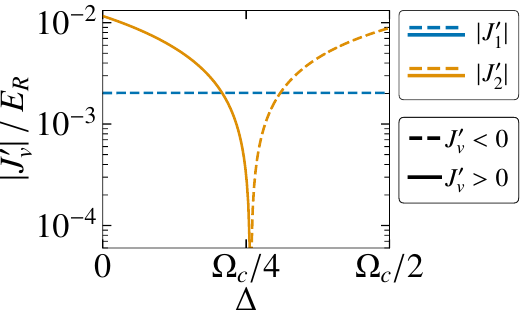
Figure 10: Absolute value of the first two tight binding tunneling parameters J (cid:48) and J (cid:48) for the first Bloch band as a function of detuning ∆ for ε = Ω 2 Ω = 2000 E and α = 0. Dashed (full) lines correspond to negative (positive) values p R of J (cid:48) v